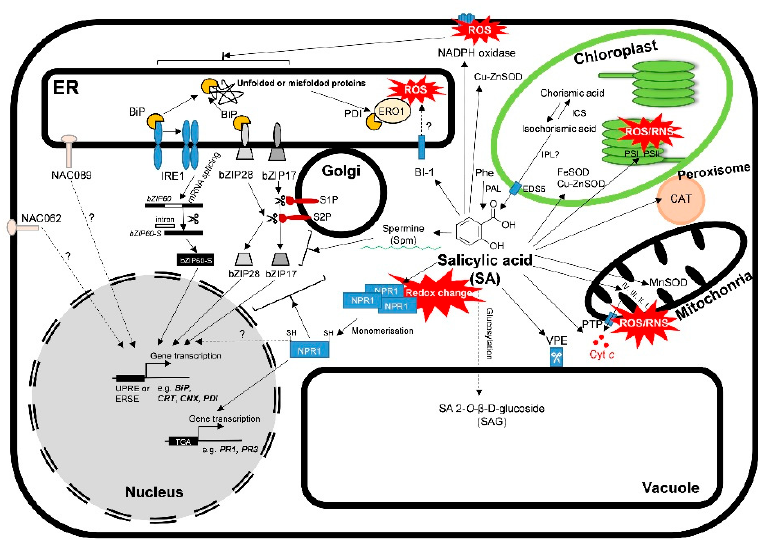
Figure 1. A schematic illustration of unfolded protein response (UPR) and the e ff ects of salicylic acid (SA) under stress condition in plants. The accumulation of unfolded proteins in the ER leads to the conformational changes and activated RNAse function of IRE1 (inositol-requiring enzyme 1), which mediates an unconventional splicing bZIP60 transcription factor mRNA. Spliced bZIP60 mRNA is translated to an active transcription factor and translocated to the nucleus and upregulates UPR genes containing unfolded protein response element (UPRE) and ER stress element (ERSE) in their promoters. bZIP28 and bZIP17 are activated by Golgi proteases (S2P and S1P). Then, the cleaved forms of bZIPs translocate into the nucleus and binds to ERSE to activate the UPR gene expression. NAC062 and NAC089 also undergo proteolytic cleavage and translocate to the nucleus to promote the transcription of UPR or cell death genes. SA has multifaceted roles in the regulation of defense or cell death processes in plants. SA is synthesized by phenylalanine ammonia-lyase (PAL) from L-phenylalanine (Phe) or in the isochorismate (IC) pathway by isochorismate synthase (ICS). Then through the activity of isochorismate pyruvate lyase (IPL) in the chloroplast, it is translocated to the cytosol by EDS5. SA induces high production of reactive oxygen (ROS) and nitrogen species (RNS) in chloroplast and mitochondria and activates NADPH oxidase, respectively. Simultaneously, SA activates various antioxidant enzymes, such as superoxide dismutases (SOD). SA induces cytochrome c (Cyt c ) release from the mitochondrial inner membrane by the permeability transition pore (PTP), decreases the transcript levels of Bax inhibitor-1 (BI-1), and increases the expression of vacuolar processing enzymes (VPEs) inducing cell death. Moreover, SA has a significant e ff ect on polyamine levels (e.g. that of spermine), influencing ER stress in plants. SA changes the redox homeostasis and induces the reduction and monomerization of NPR1, which is translocated to the nucleus where it binds to specific TGA transcriptions factors, inducing the expression of SA-induced defensive response genes (PRs). SA can be inactivated and stored as SA O- β -glucoside (SAG) in the vacuole. Detailed description and references are in the text